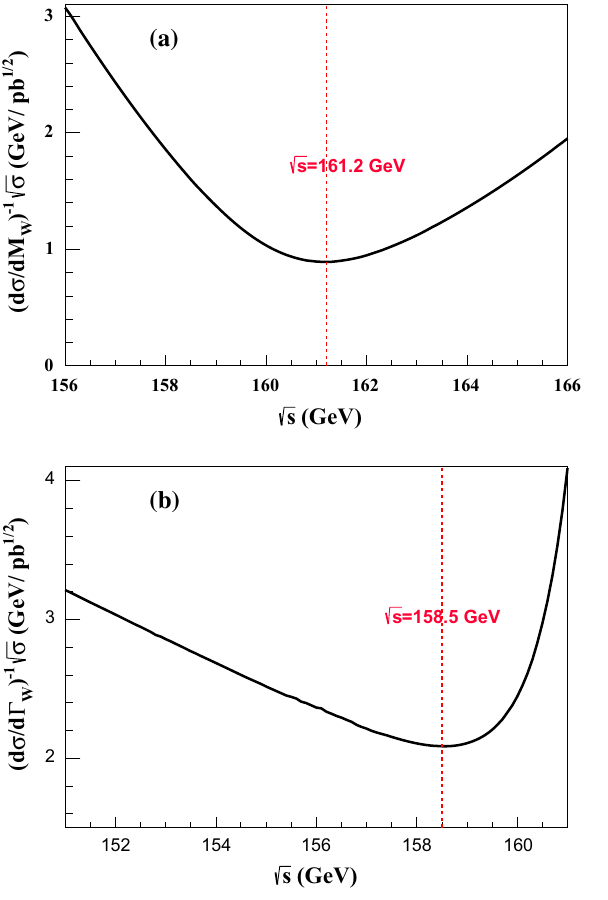
Fig. 5 (a)The dependence of the statistical uncertainties of the mea- sured results on the statistic of data. (b)The decline rate of the statistical uncertainty to luminosity. The black (red) solid line shows the result for measuring the m W ( Γ W ) only, and the black and red dots show the results for measuring the m W and Γ W simultaneously. The energy 162.5 GeV is used for m W and 158.5 GeV is used for Γ W , and they are both used when the mass and width are fitted